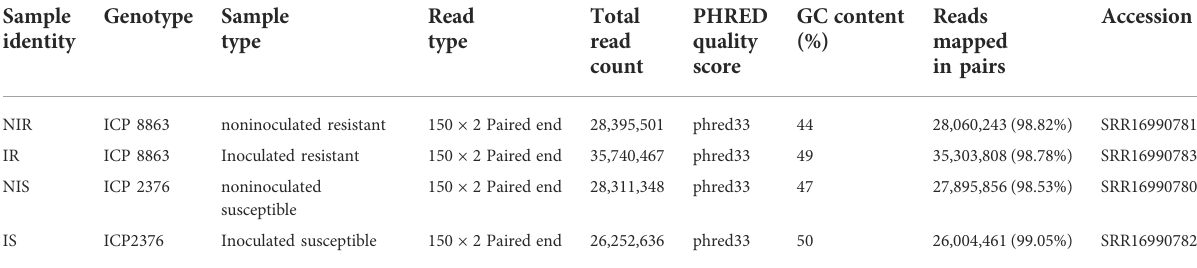
TABLE 1 Statistical summary of the transcriptome data output with their NCBI-SRA accession numbers.